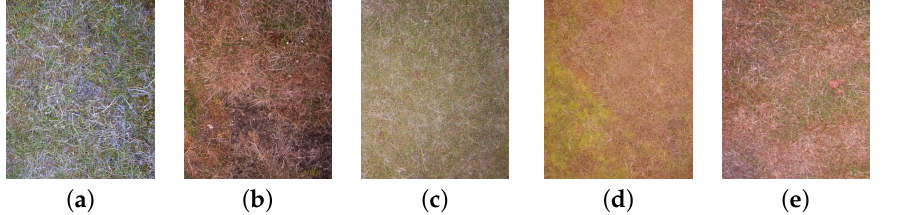
Figure 2. Images recorded on 27 July 2018 from stations ( a ) ST1, ( b ) ST3, ( c ) ST6, ( d ) ST7, and ( e )